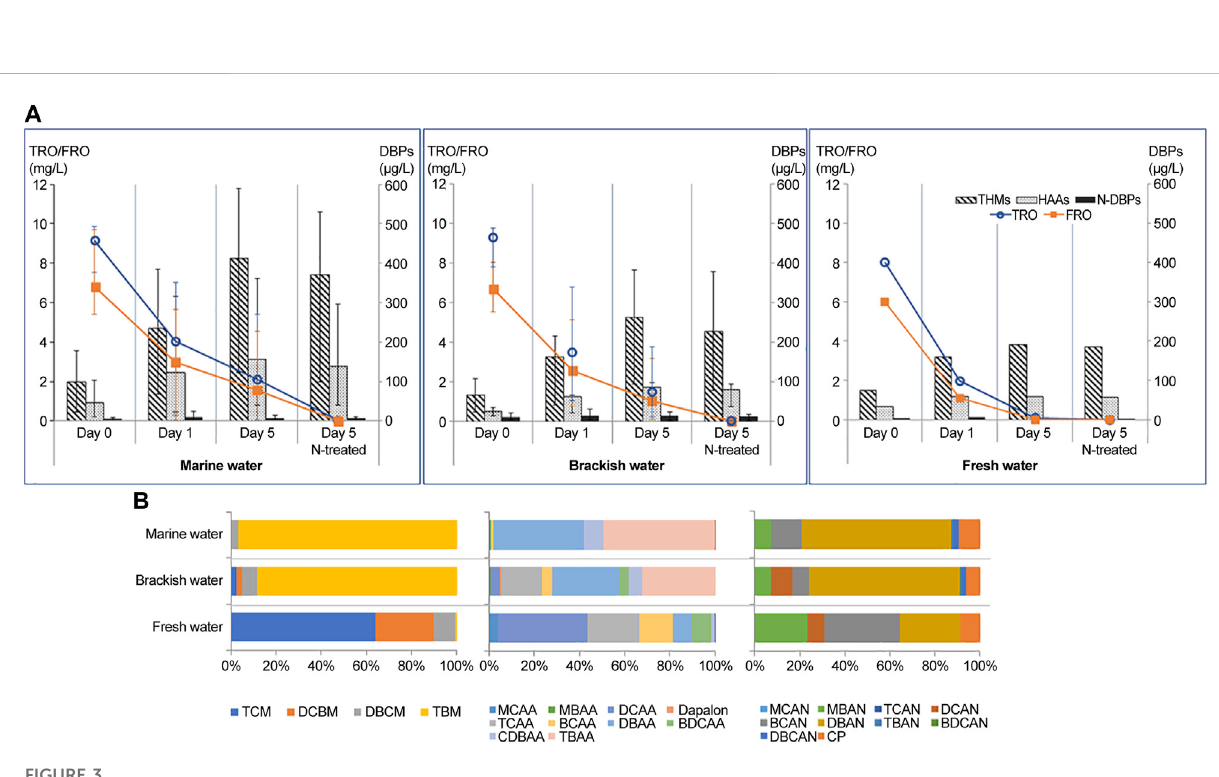
FIGURE 3 (A) Variations in the concentrations of total residual oxidants (TROs), free residual oxidants (FROs), and DBPs in electrolytic ballast water management systems (BWMSs); (B) proportion of DBPs before neutralization of treated water (day